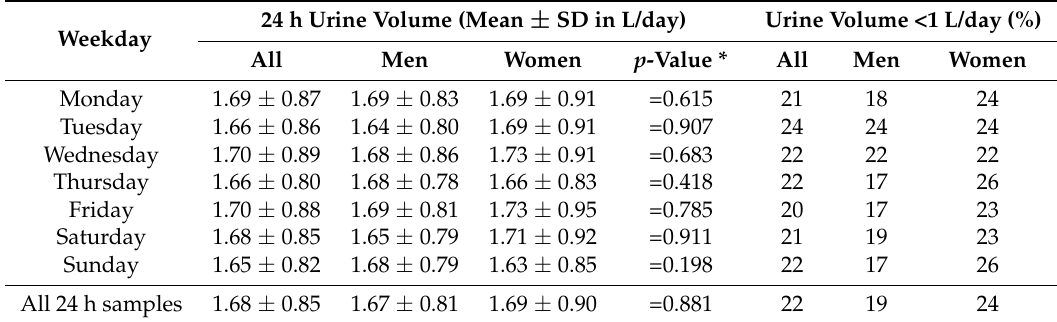
Table 4. Mean 24 h urine volume (L/day) on weekdays and percentage of subjects with a urine volume <1 L/day, for men and